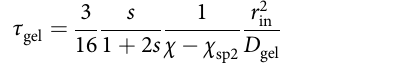
experimentally accessible.